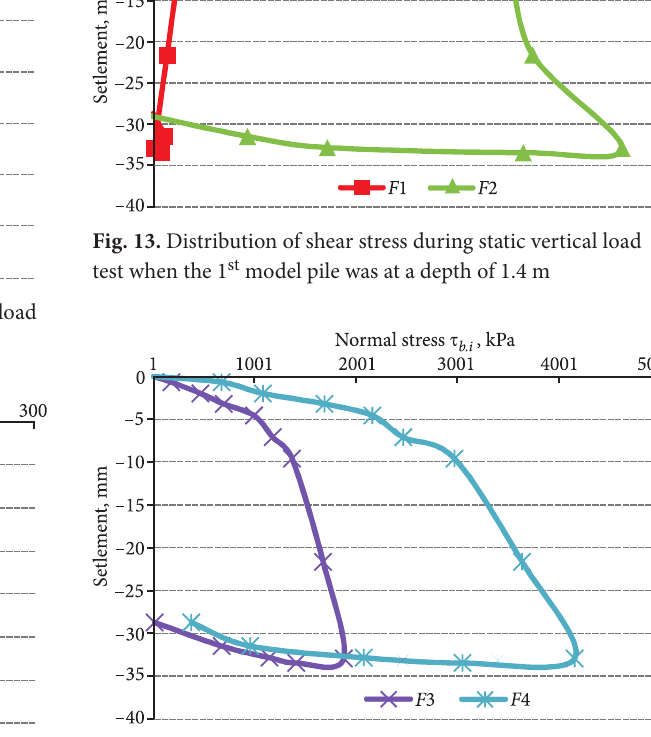
fig. 12. Load – settlement curve when the 1 st model pile was at a depth of 1.4 m